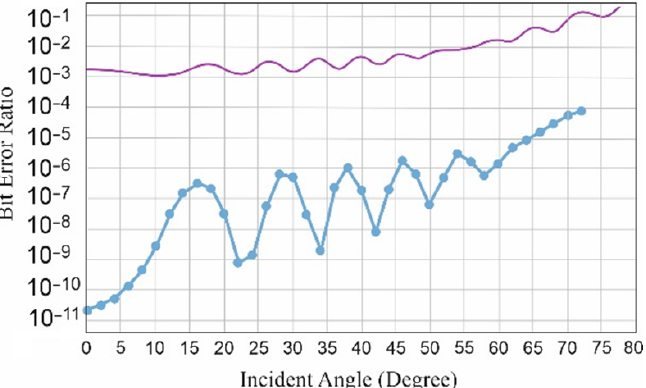
Figure 7. Modelled BER of SPAD receiver (upper curve) in dependence on the light incidence angle compared to the BER of the APD receiver (lower curve) [38].